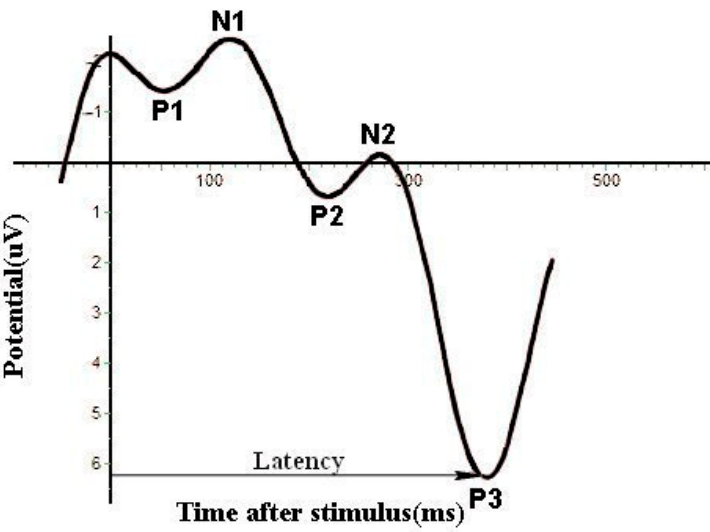
Figure 1. ERP components after the onset of an audio stimulus, including the P300 (labeled P3) and N200 (labeled N2). Generally, the Y-axis scales are often upside down in ERP research.